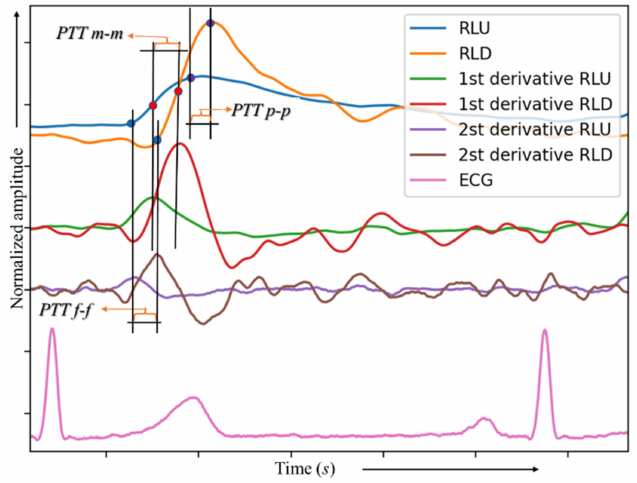
Figure 6. Pulse transit time PTT: peak-to-peak PTT (PTTp-p), middle-to-middle PTT (PTTm-m), and foot-to-foot PTT (PTTf-f).